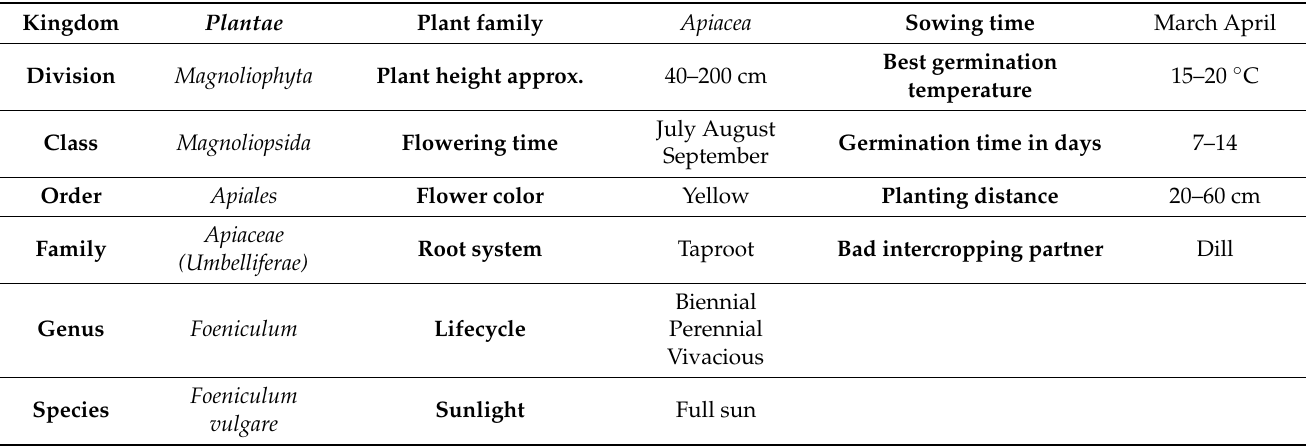
Table 1. Classification and description of fennel plant (https://plants.usda.gov accessed 11 Febru- ary 2022).